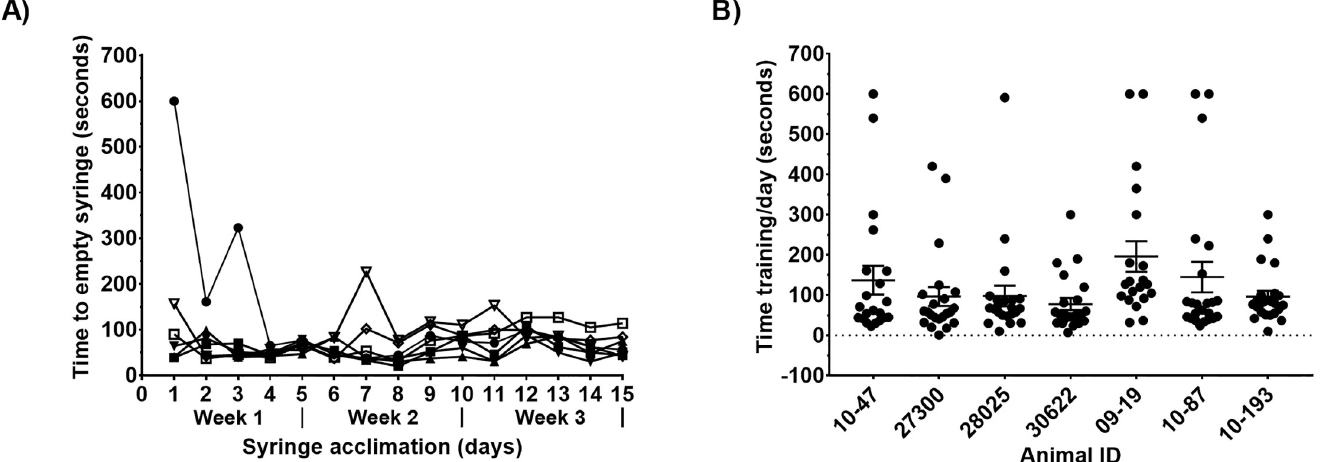
Fig 1. Positive reinforcement training. A) Acclimation to syringe for juice training . Male rhesus macaques (n = 7) were enrolled in a PRT program which used sweet liquids administered from a 60-cc catheter tip syringe as a reinforcer. Syringe acclimation was done over a period of three weeks, with training five days a week. Liquids tested included fruit juices (mango, apple, cranberry, passion fruit, pomegranate, and peach), diluted strawberry syrup, diluted molasses, vanilla ensure, kefir, yogurt and chocolate milk. Each individual animal is represented by a distinct shape/fill. B) Daily positive reinforcement training (PRT) time . Animal and trainer interactions were timed during training sessions with a stopwatch. Times when the animals did not successfully complete any desired behavior are included. Data shows results obtained over a two-month period when animals were trained to shift location in their cage, sit and accept liquid from a syringe. Individual daily training times are represented by circles; bars denote mean ± SEM.